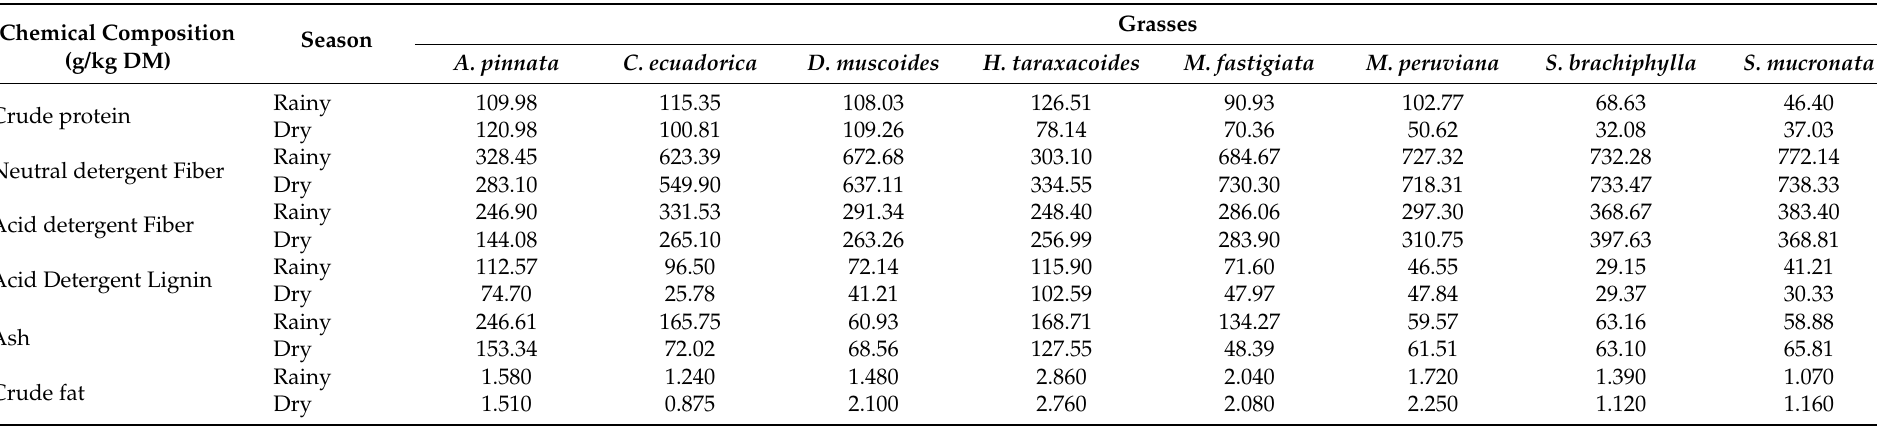
Table 1. Chemical composition of natural grasses in the rainy and dry